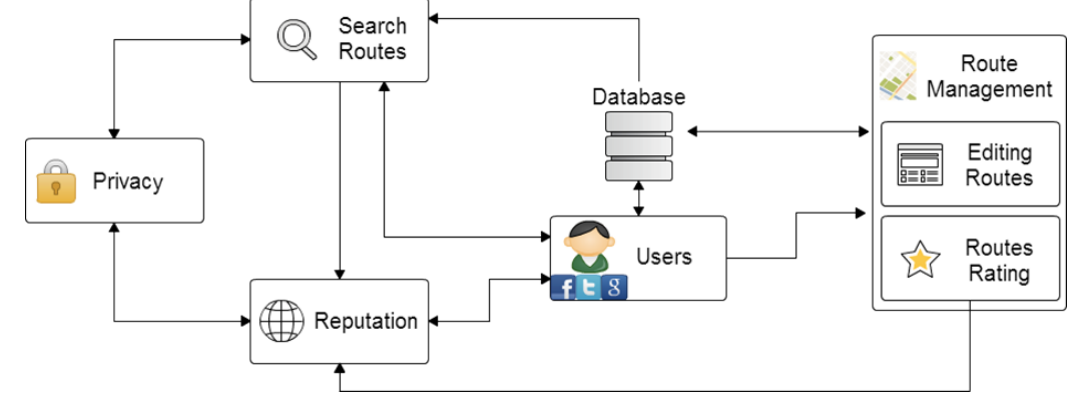
Figure 5. Use Model of the Implemented